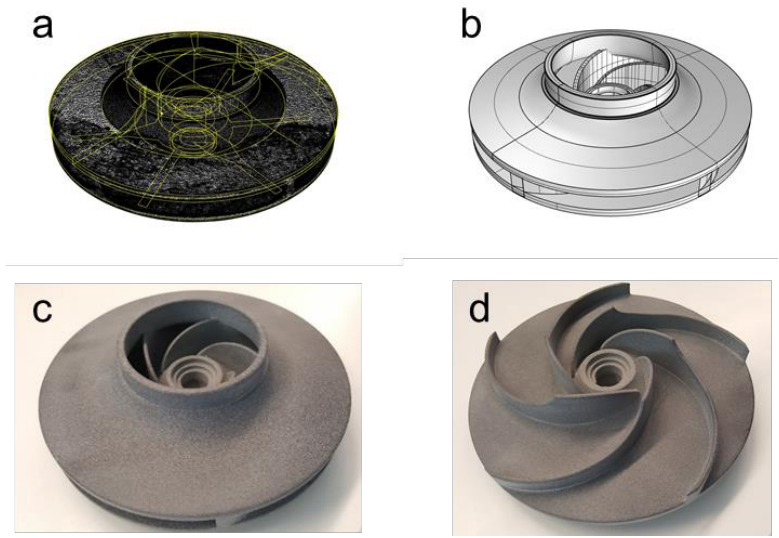
Figure 5. Impeller digitizing and design: ( a ) 3D scan with curves, ( b ) solid surface view, ( c , d ) PA12 communication model.